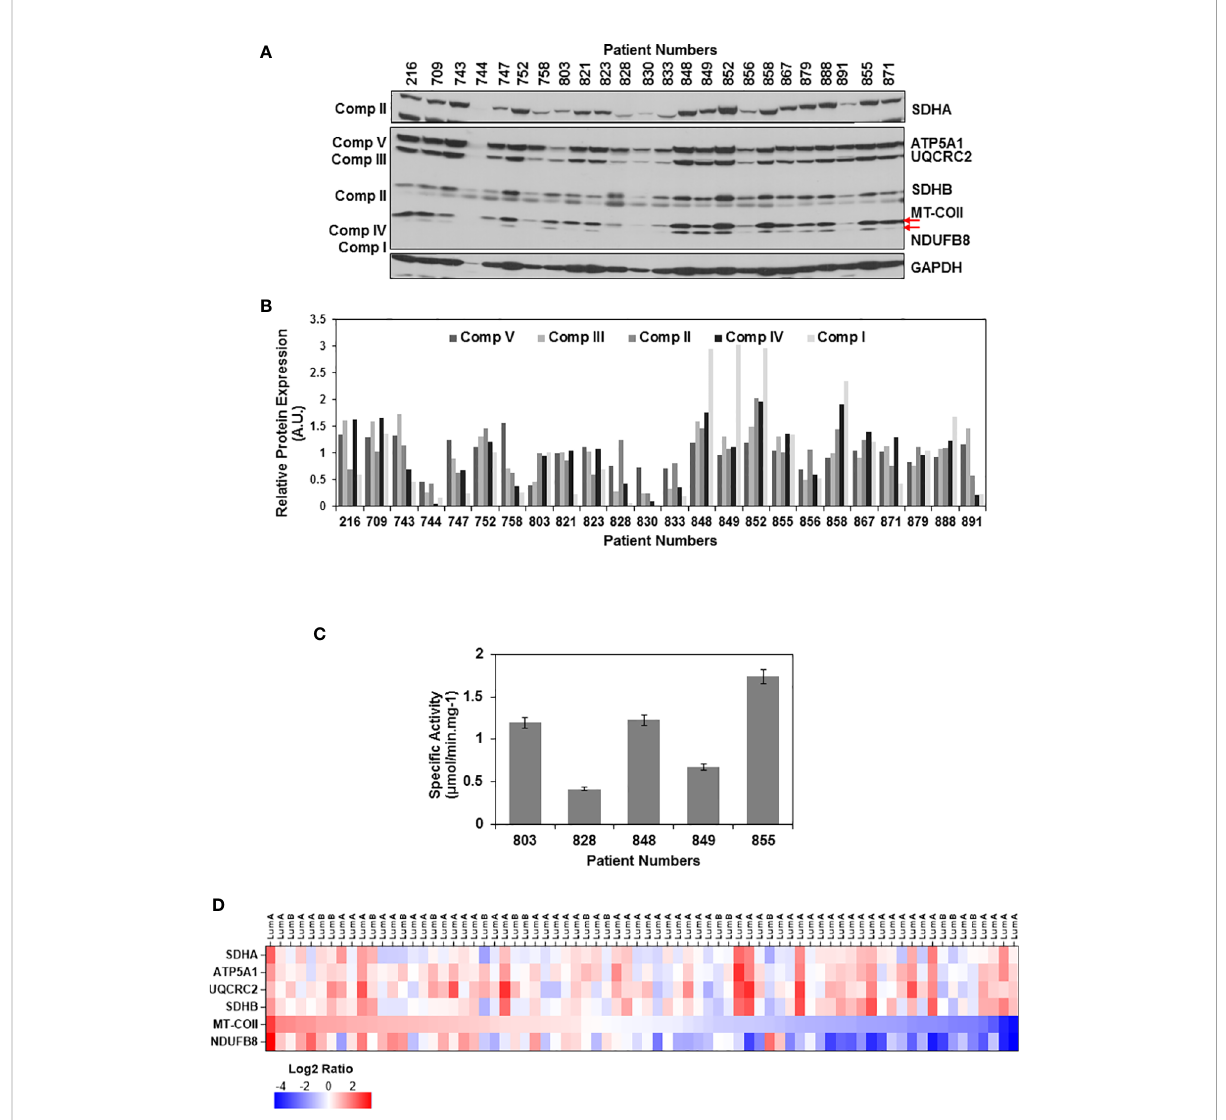
FIGURE 1 OXPHOS subunit expression heterogeneity in ER/PR(+) breast cancer. (A) The expression of OXPHOS subunits, including ATP5A1 (Complex V), UQCRC2 (Complex III), SDHA and SDHB (Complex II), MT-COII (Complex IV), and NDUFB8 (Complex I),were detected by immunoblotting in ER/ PR(+) invasive ductal carcinoma biopsy lysates. Approximately, 20 m g of protein lysates obtained from tumor tissues was separated by 12% SDS- PAGE, and equal protein loading was evaluated by GAPDH antibody and Ponceau S staining (see Figure S2). (B) Quantitation of OXPHOS subunit expression in patient tumor biopsies by normalizing average signal intensities for each antibody to protein loading. AU; arbitrary units. (C) Complex IV speci fi c activity was determined by measuring the rate of cytochrome c oxidation at 550 nm using equal amounts (~20 m g) of biopsy lysates selected from patients expressing high, medium, and low levels of MT-COII as shown in panel A. Results represent the mean ± SD of at least three experiments. (D) Heatmap representation of log2 ratios of OXPHOS subunit expression in luminal A and B subtypes of breast cancer detected by MS-based proteomics published by Krug et al. (65) (Table S2). Only the ER/PR(+) luminal A and B subtypes analyzed by the CPTAC used in the fi gure. The expression of OXPHOS subunits is ranked from high (red) to low (blue) MT-COII log2